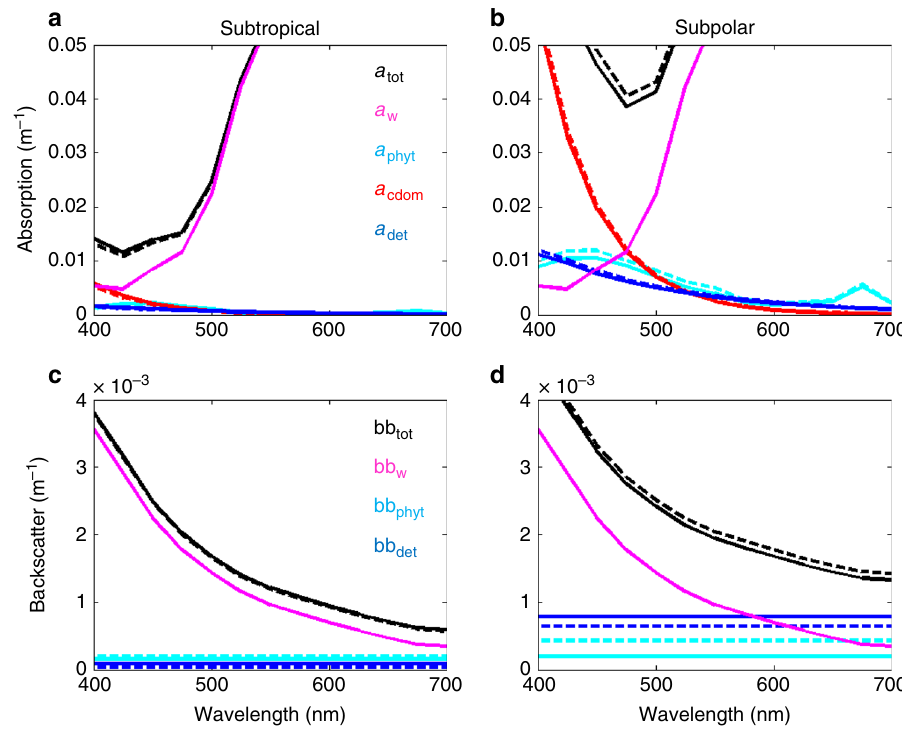
Fig. 6 Absorption and backscatter. Components of total absorption ( a , b ) and backscattering ( c , d ) for two locations: middle of the oligotrophic subtropical gyre (circle in Fig. 4) ( a , c ) and the productive subpolar gyre in the North Atlantic ( b , d ). Units are m − 1 . Solid lines are for current day (15 year mean) and dashed lines are for the mean of the last 15 years of the 21st century. Black is for total, purple for water, red for coloured dissolved organic matter (CDOM), light blue for phytoplankton, and dark blue for detrital